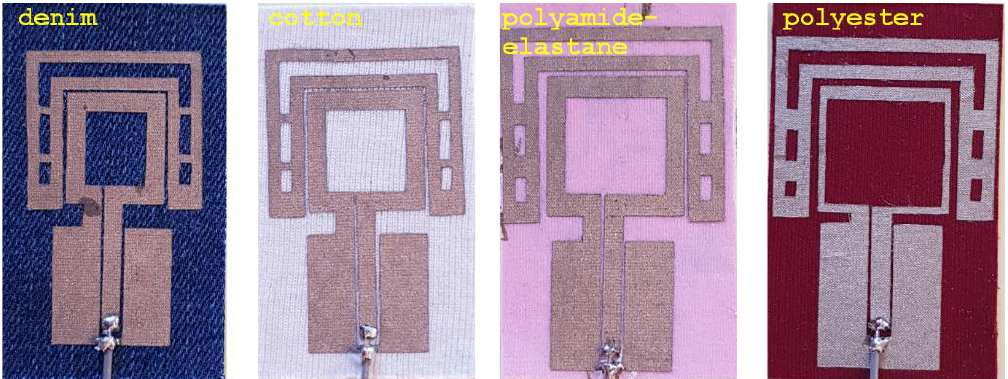
Figure 14. Photographs of the fabricated prototypes with a substrate from denim, cotton, polyamide-elastane and polyester.